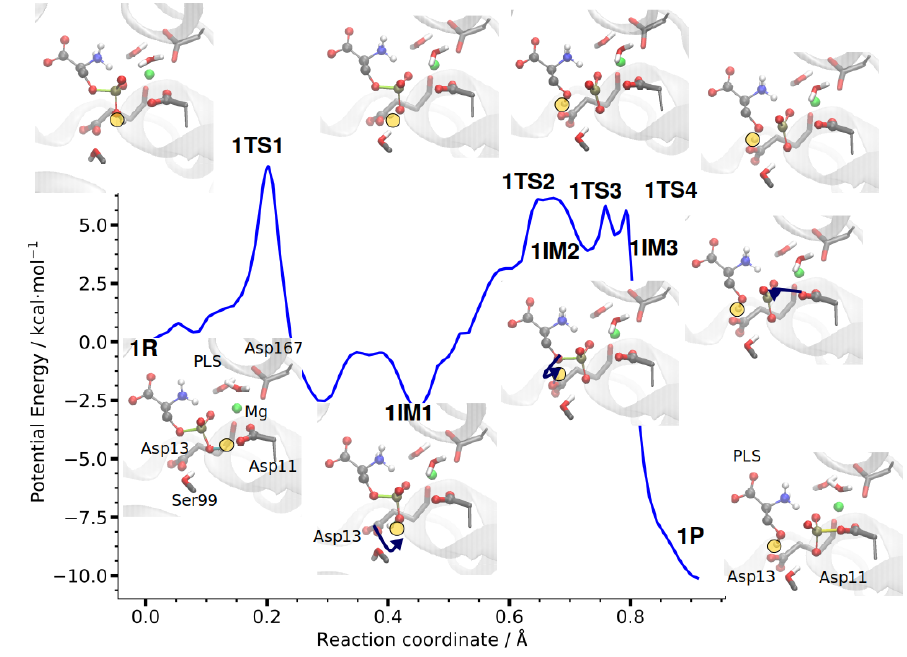
Figure 5. DFTB/MM energy profile of the first phosphate transfer step in PSP. The insets show active site residues of the reactant state, 1R, intermediate states, 1IM1, 1IM2, and 1IM3, and product state, 1P, as well as the transition states in between. The transferred protons are highlighted in yellow, P-O bonds formed or broken in the course of the reaction are also coloured yellow. Arrows indicate the transitions: First, the proton of the phosphate group rotates towards the oxygen atom of Asp13 (1R to 1IM1). Then, this proton is transferred to Asp13 (1IM1 to 1IM2) A further proton transfer from Asp13 to the leaving group oxygen atom (1IM2 to 1IM3) is accompanied by the dissociation of the P–O bond. The resulting high-energy intermediate is attacked by Asp11 resulting in the formation of the phosphoryl-aspartate